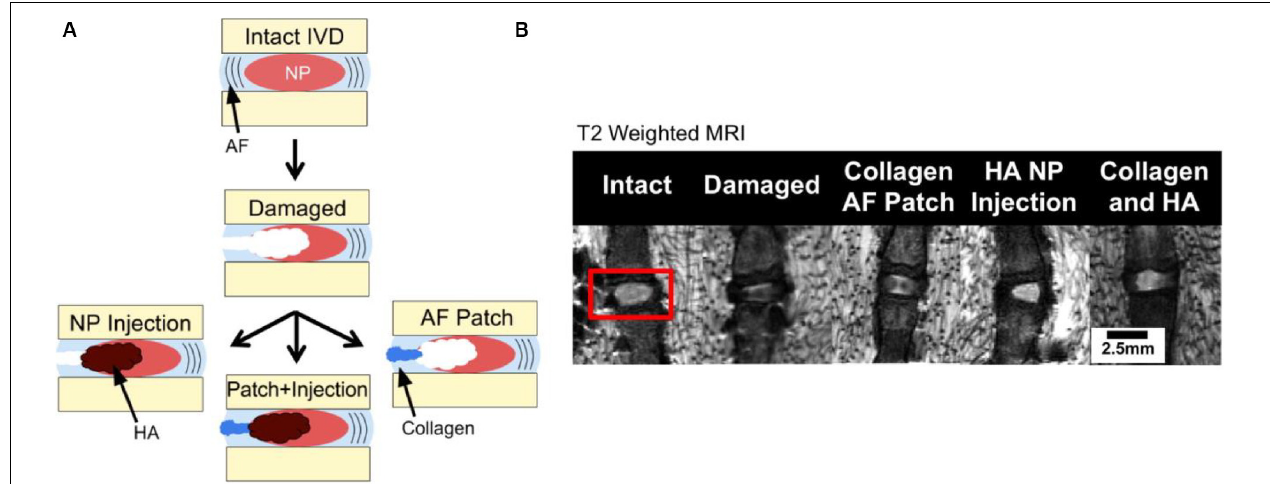
FIGURE 4 | (A) Segments test via annulotomy/nucleotomy and (B) MRI images of NP hydration and morphology where hyperintense regions correspond with greater relaxation time and hydration. Reproduced from Sloan et al. (2017) with permission from Copyright 2017